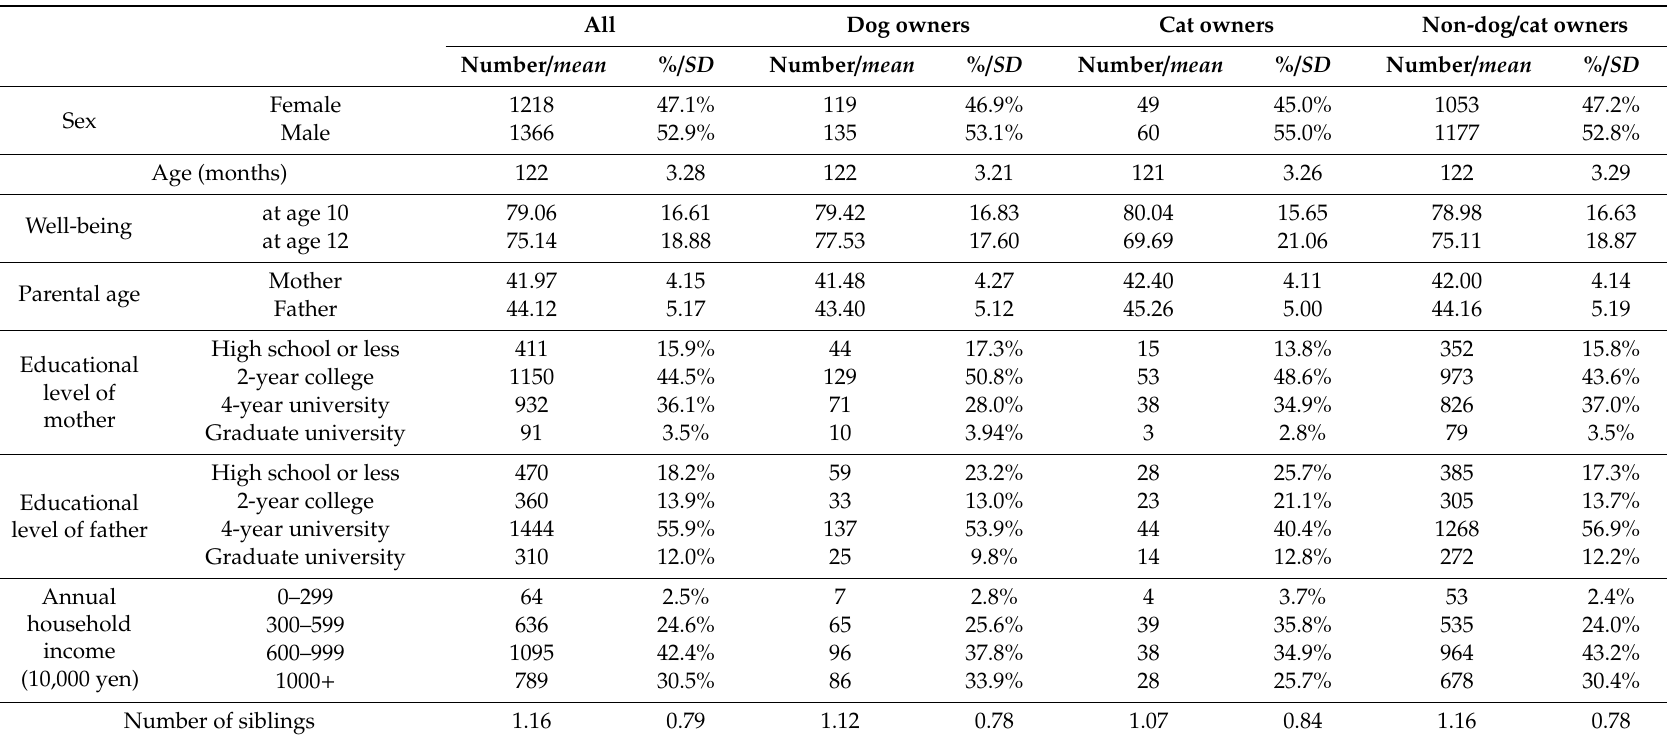
Table 1. Demographic characteristics of participants (N =